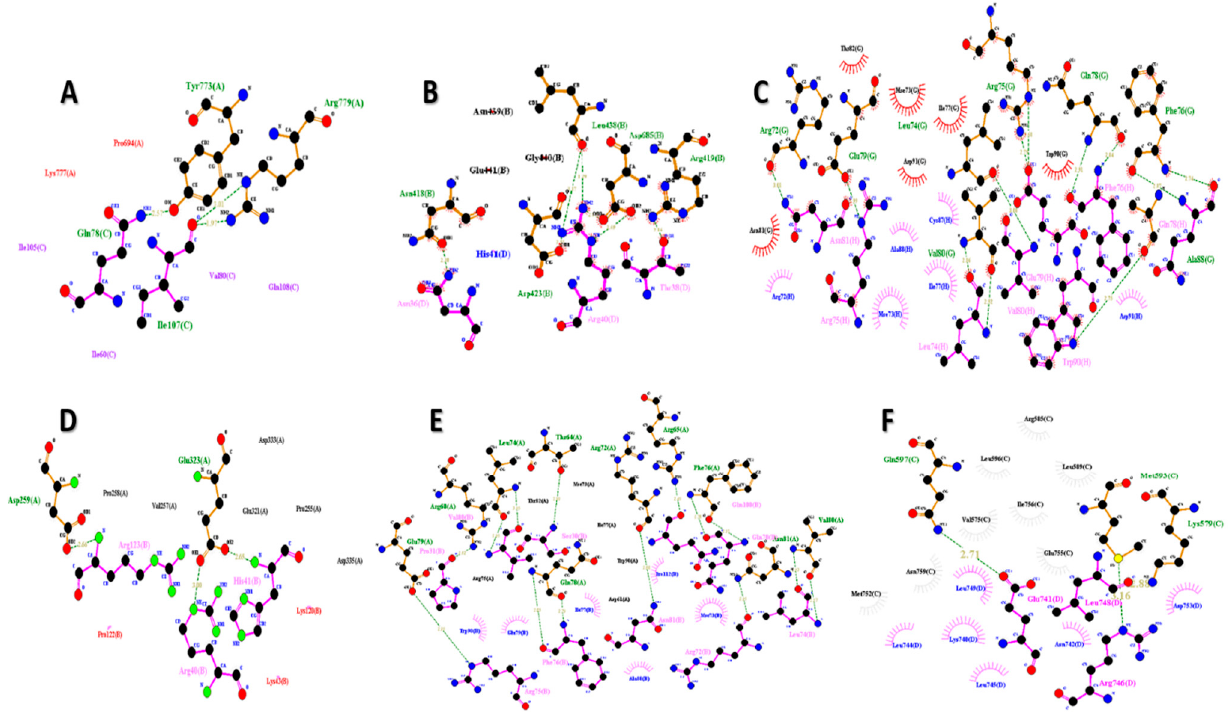
Figure 6. The FNDC5 or irisin (pink; ligand residues) amino acid residues interacting with receptors ( A ) Androgen ( B ) DDB1 and CUL4 associated factor 6 ( C ) Estrogen-related receptor β ( D ) Estrogen-related receptor γ ( E ) Krüppel-like factor 15 ( F ) Nuclear receptor subfamily 3 group C member 1 (all the receptors interacting residues are in green color).